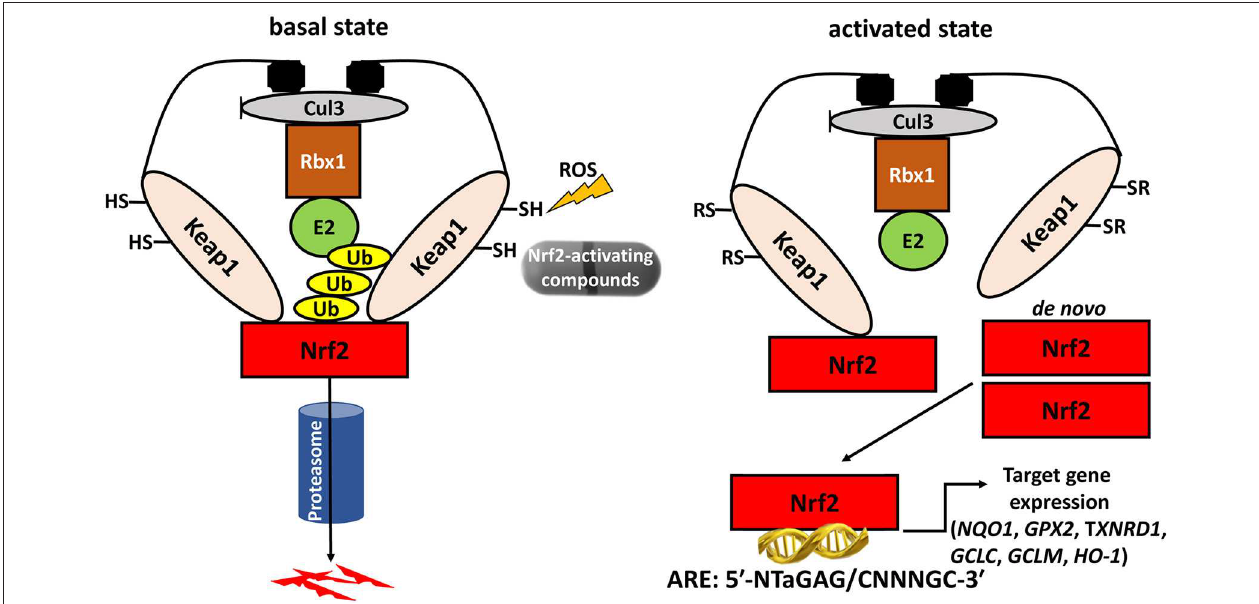
FIGURE 1 | The Keap1/Nrf2 system. Under basal conditions, Nrf2 is bound to its cytoplasmic inhibitory complex formed by Keap1 and Cul3 that targets Nrf2 for polyubiquitination and subsequent degradation by the proteasome. When oxidative stress occurs, the interaction between Nrf2 and the inhibitory complex is abrogated, leading to accumulation of de novo synthesized Nrf2 in the nucleus. Nrf2 then promotes the transcription of antioxidant and cytoprotective genes via binding to Antioxidant Response Elements (AREs) located in the genes’ regulatory regions. Cul3: Cullin3; Rbx1: RING-box protein 1; E2: ubiquitin-conjugating enzyme 2; Ub: Ubiquitin; Keap1: Kelch-like ECH-associated protein 1; Nrf2: nuclear factor erythroid 2-related transcription factor 2; NQO1 : NAD(P)H quinone dehydrogenase 1; GPX2 : glutathione peroxidase 2; TXNRD1 : thioredoxin reductase 1; GCLC : glutamate-cysteine ligase, catalytic subunit; GCLM : glutamate-cysteine ligase, modifier subunit; HO-1 : heme oxygenase